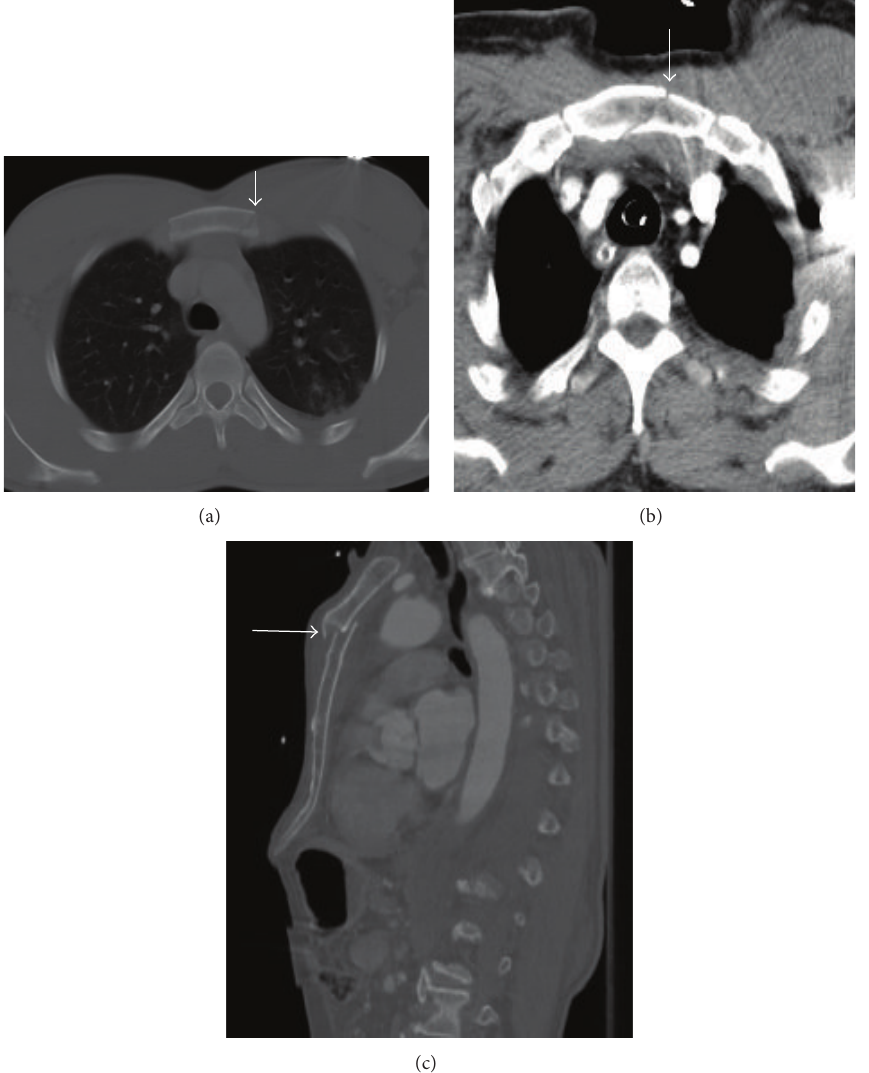
Figure 14: Sternum fracture in two different patients. Axial MDCT (bone window) in patient one (a) shows a complete sternum fracture at the level of the body, without displacement of the fragments (arrow). Axial MDCT (b) and sagittal reconstruction in bone window (c) in a second patient show a displaced sternal body fracture (arrows). A small retrosternal hematoma is also seen